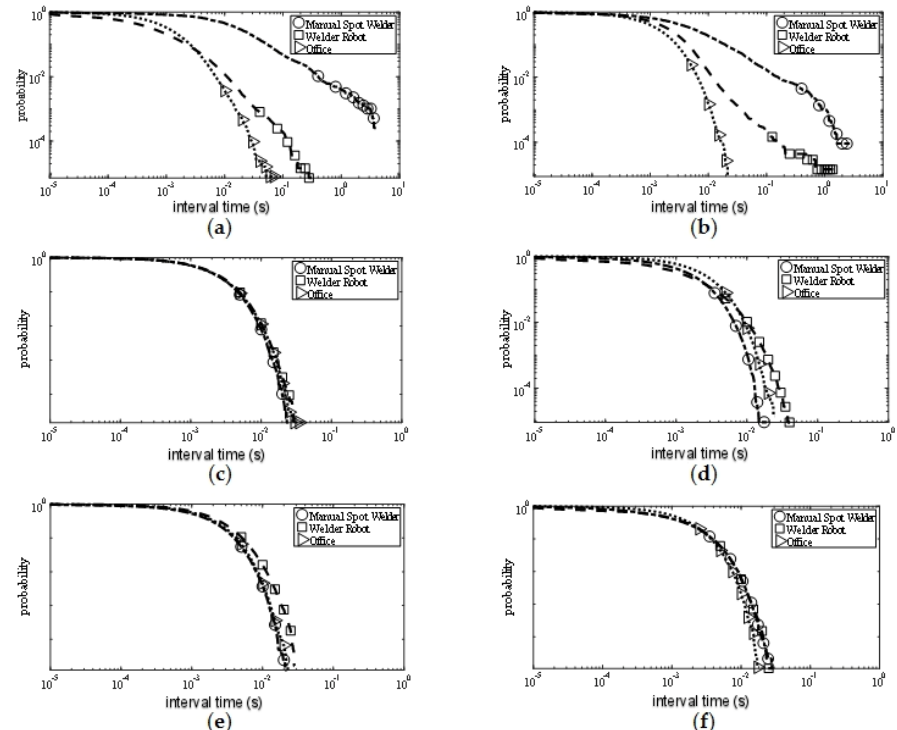
Figure 9. Pulse separation distribution (PSD) results. ( a ) PSD of vertical polarization at 315 MHz; ( b ) PSD of horizontal polarization at 315 MHz; ( c ) PSD of vertical polarization at 779 MHz; ( d ) PSD of horizontal polarization at 779 MHz; ( e ) PSD of vertical polarization at 916 MHz; ( f ) PSD of horizontal polarization at 916 MHz.